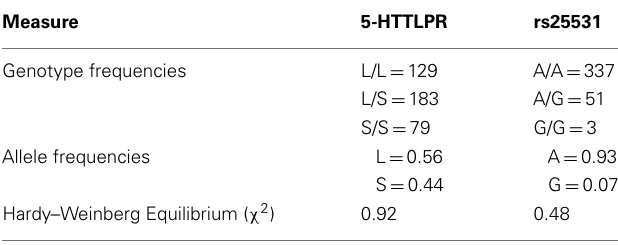
Table 1 | Genotype data for the N = 391 Caucasian participants at two serotonin transporter